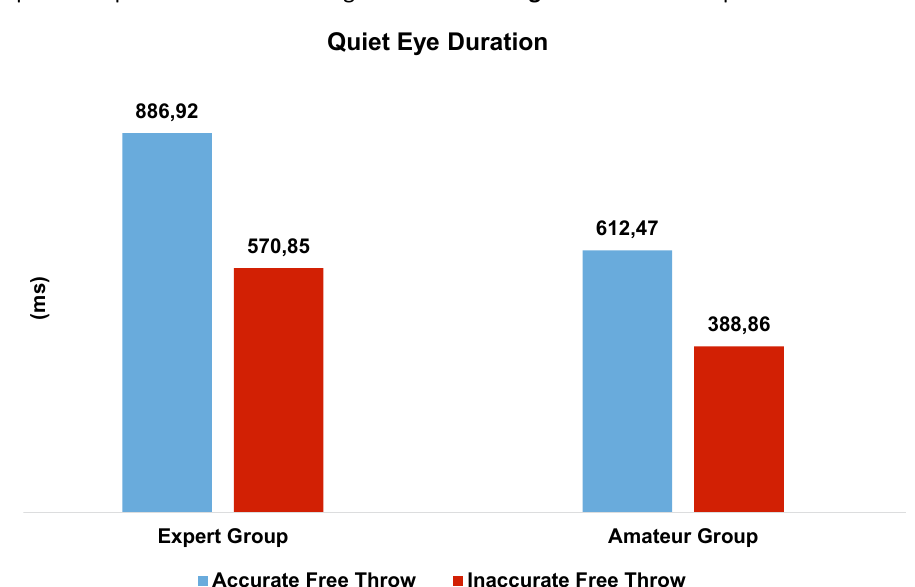
Fig. 5. Quiet eye duration of expert and amateur groups inaccurate and inaccurate free